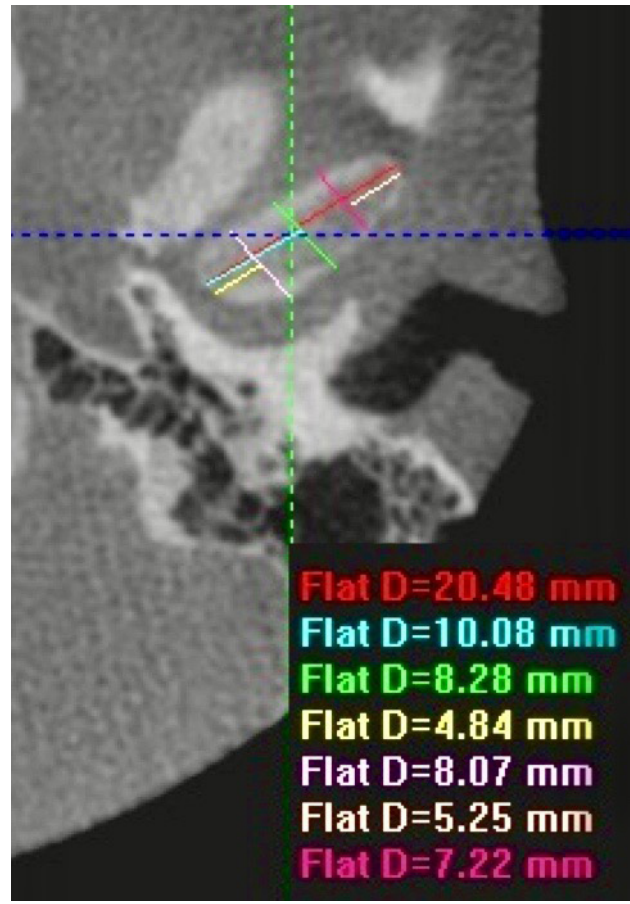
Fig.2. Axial measurements: lateral-medial (red), posterior-anterior central (green), posterior-anterior lateral (pink) and posterior-anterior medial (light pink), carried out in the condyles. The other measures that appear (yellow, light blue and salmon) were performed to determine the locations of the axial measurements.